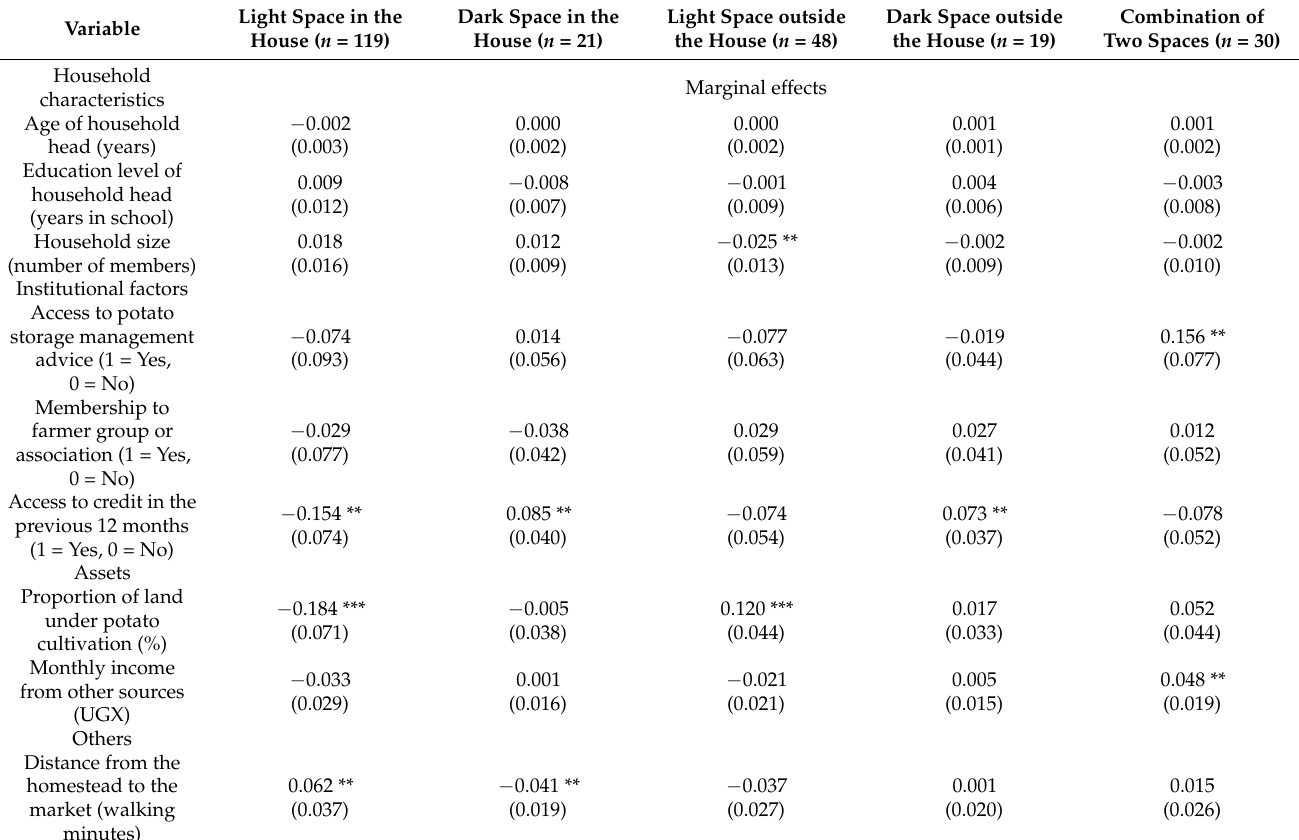
Table 10. Factors influencing the choice of storage technologies by potato